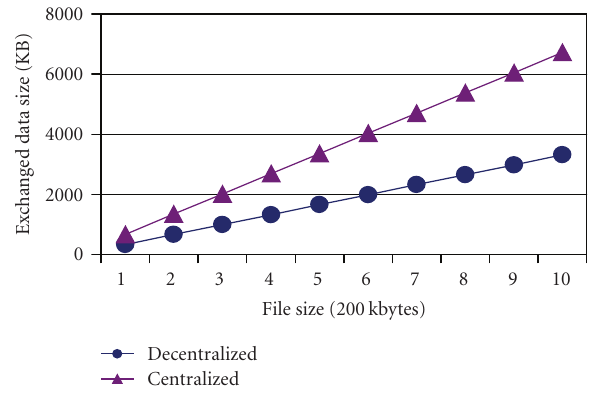
Figure 13: Exchanged data size versus file size. (Bandwidth = 54 Mbps, three services are